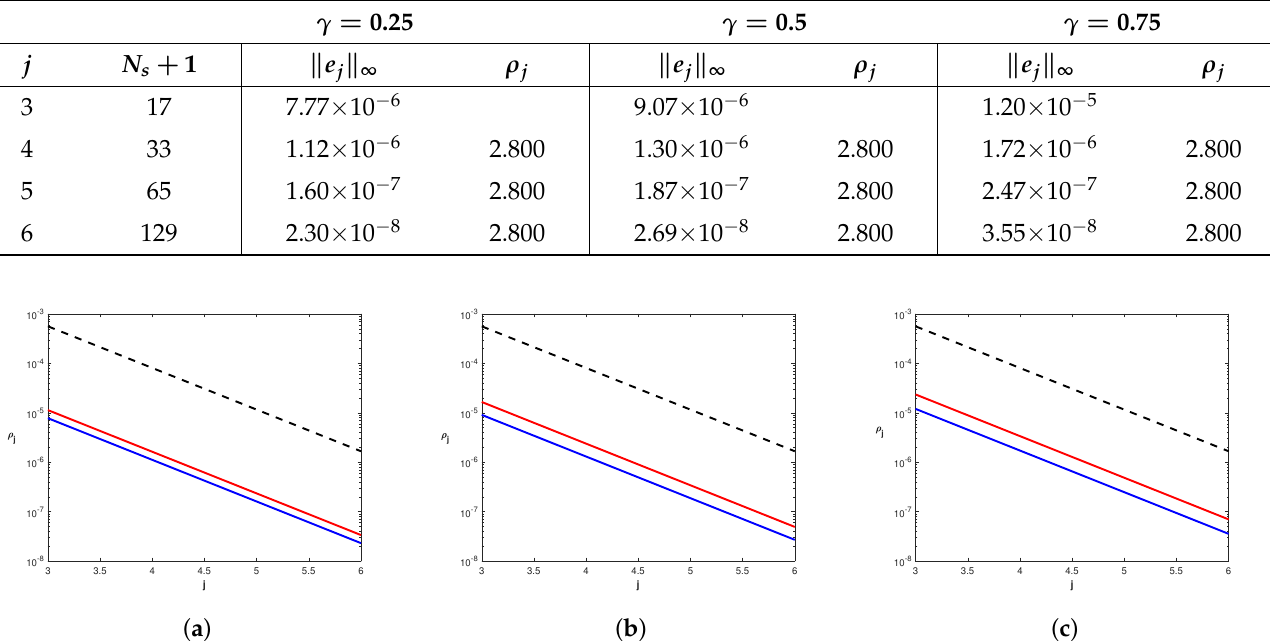
Figure 2. Example 1: The numerical convergence order ρ j for the quasi-interpolatory operator with r = 1 (red solid line) and r = 2 (blue solid line) for γ = 0.25 (Panel ( a )), γ = 0.5 (Panel ( b )), and γ = 0.75 (Panel ( c )) is displayed as a function of j . The black dashed line has the same slope as the theoretical convergence